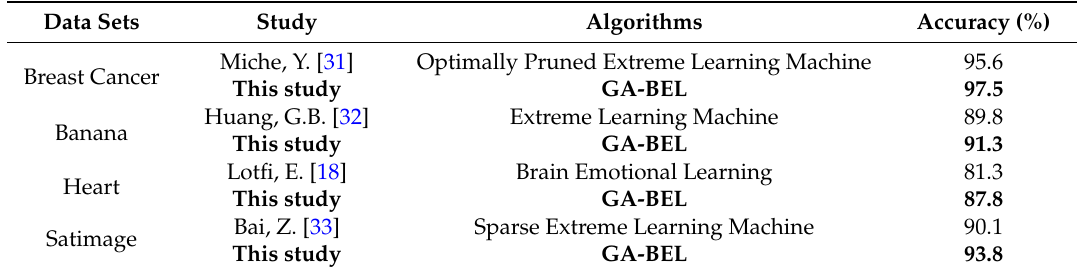
Table 5. Classification accuracies obtained by the proposed method and the previous